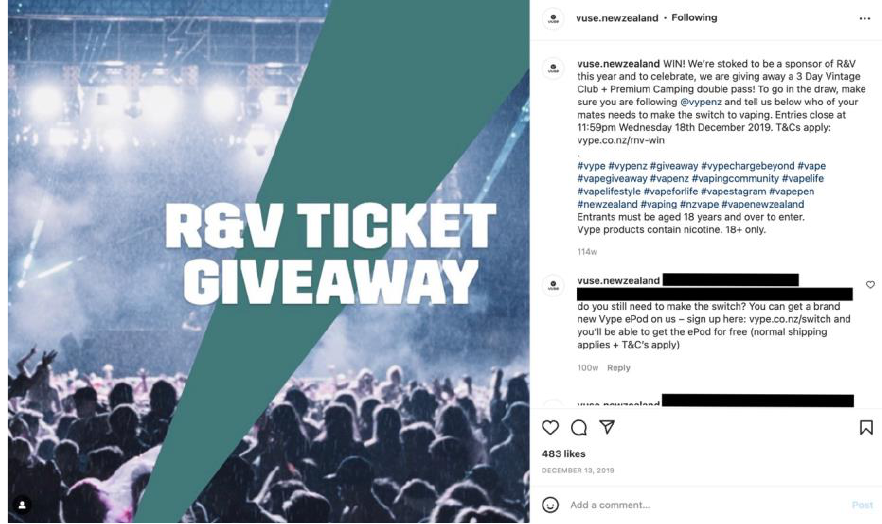
Figure 4. Example of an Instagram post promoting a music festival giveaway.